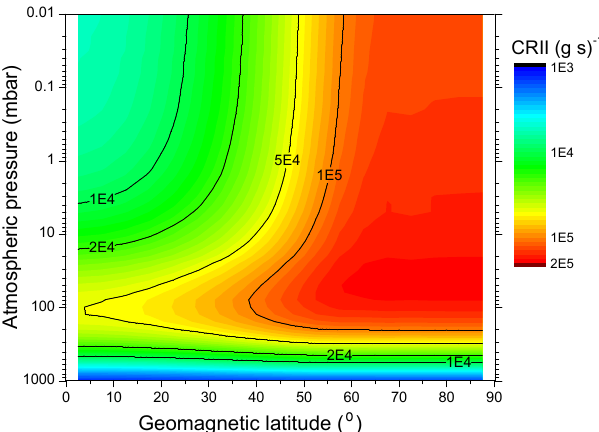
Figure 20. Calculated annual mean ion pair production rate for the year 2014 as a function of barometric pressure and geomagnetic latitude. Computations were done using the CRAC:CRII